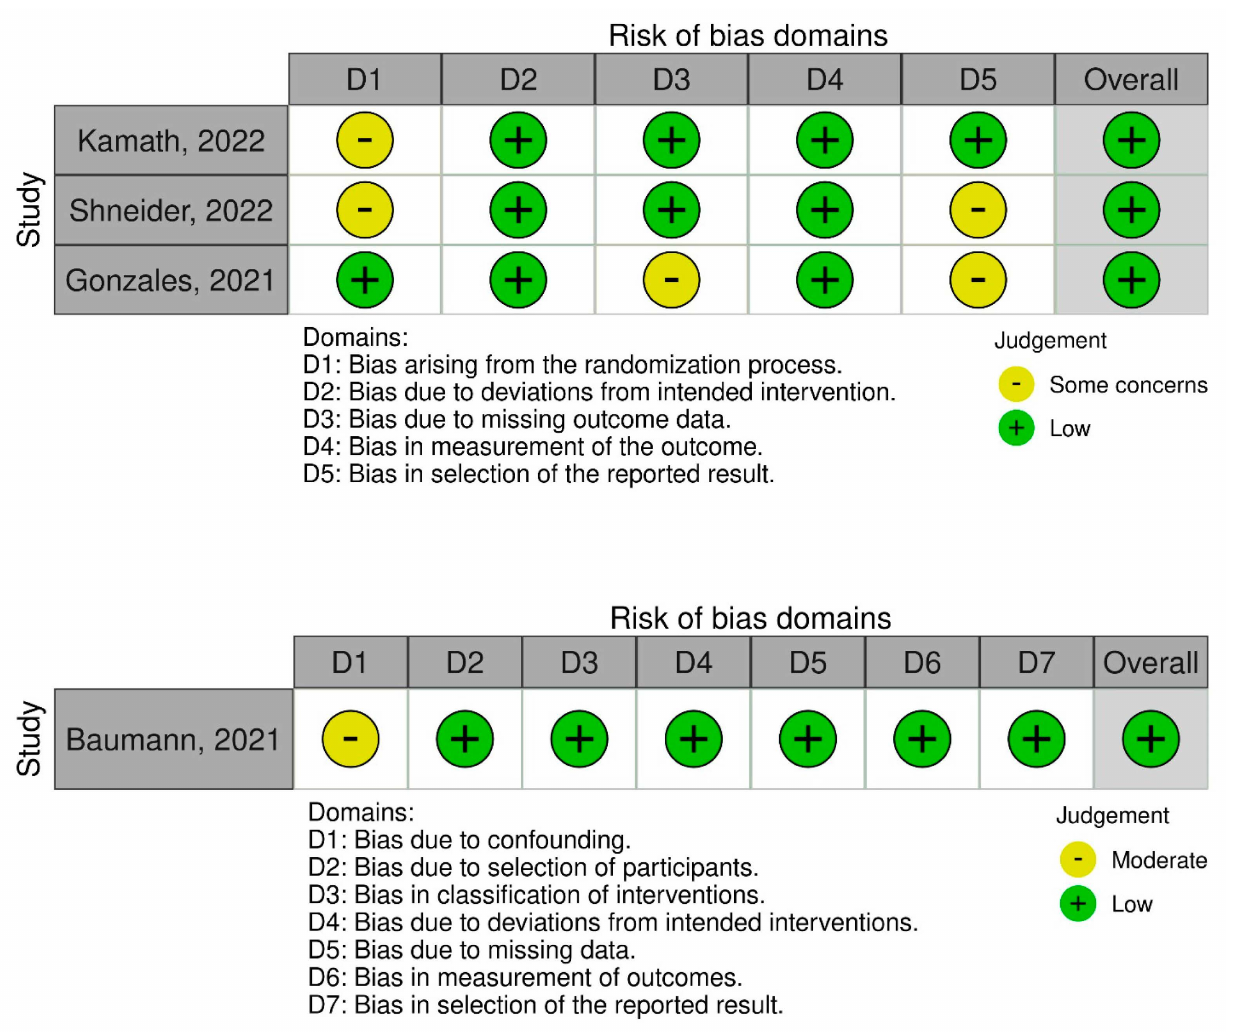
Figure 8. Risk of bias assessment of RCTs using the ROB 2 and ROBINS-I tools. The traffic light plots depict study-by-study bias assessment